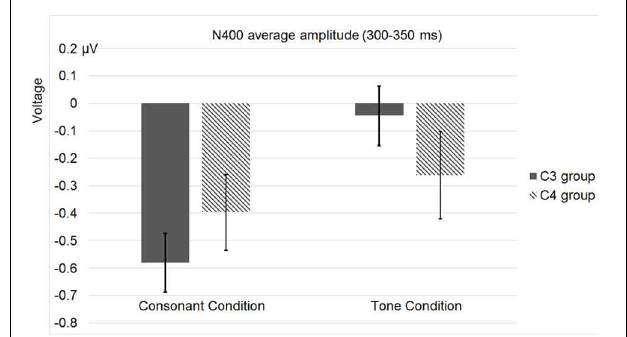
FIGURE 14 | Average N400 (300–350ms) amplitudes of the C3 and C4 electrode groups in Experiment 3. “Consonant” and “tone” denote the consonant and tone violation